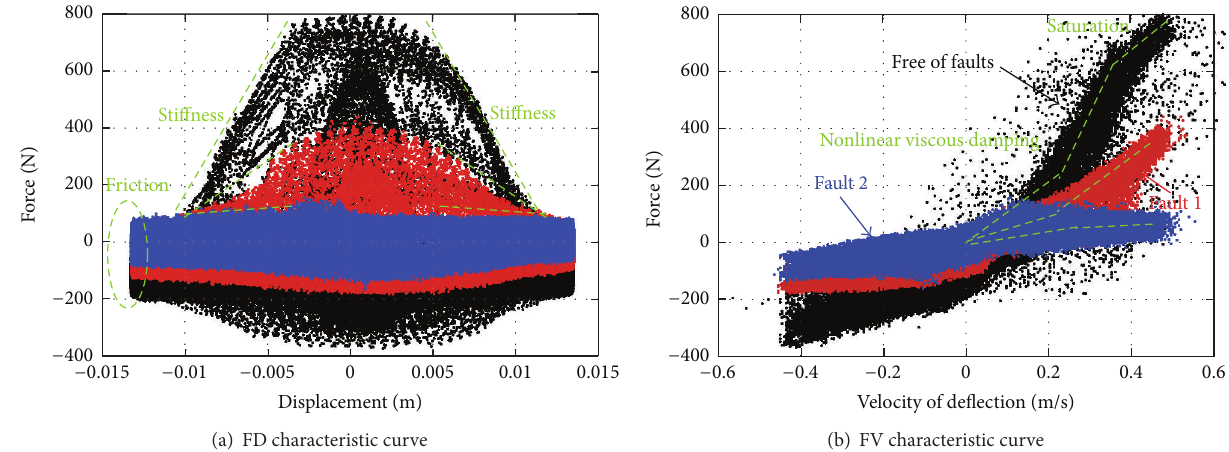
Figure 1: Experimental characteristic curves of a damper subject to leakages. Fault 1 represents 5% of oil leakage and fault 2 10%. The damper does not have control input value.